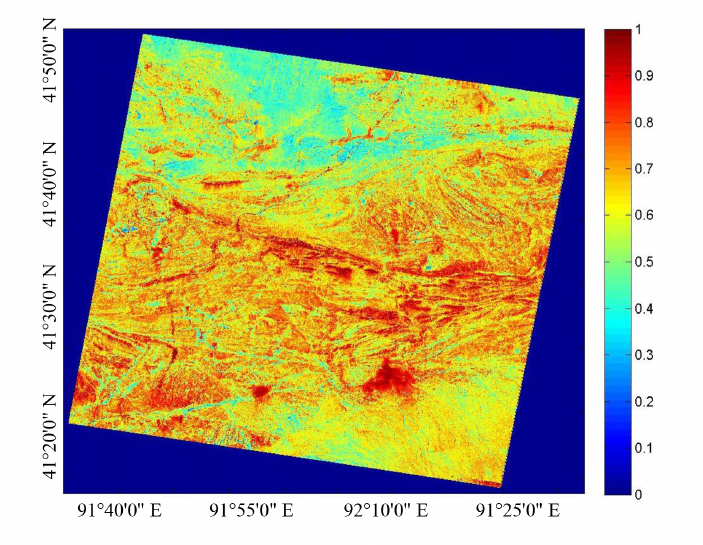
Figure 9. The SNR coherence map of the test site.